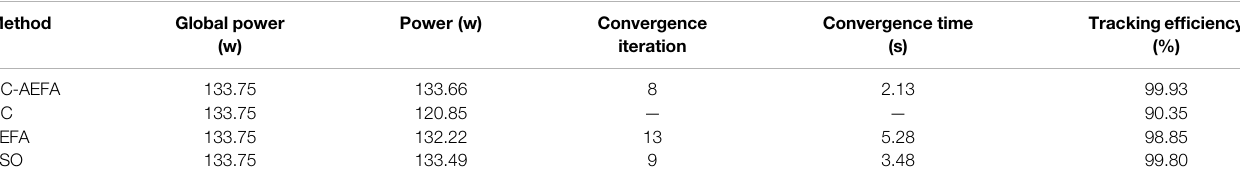
Figure 9 shows the algorithm-based population optimization process for the various MPPT methods in the case of the second pattern. For the AEFA, PSO, and proposed